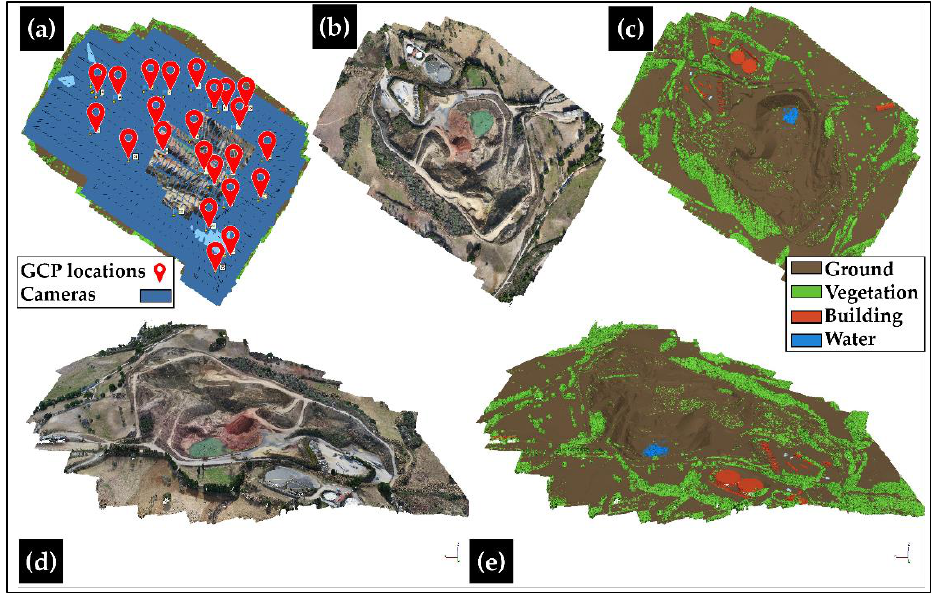
Figure 2. ( a ) Camera coverage and Ground Control Point (GCP) locations. ( b ) 2D nadiral perspective of RGB colored point cloud. ( c ) 2D nadiral perspective of point cloud classification (ground points were used for the DEM construction). ( d ) 3D perspective of RGB colored point cloud. ( e ) 3D perspective of point cloud classification. Source: Drone imagery acquired during this study processed with Metashape Photoscan by the authors.